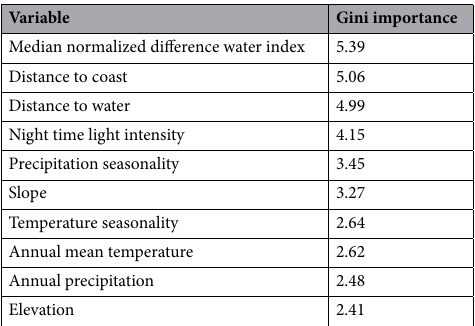
Table 2. Relative importance of environmental variables in the random forest model rated by Gini importance (mean decrease in Gini impurity); variables with high Gini importance values have a higher predictive value.